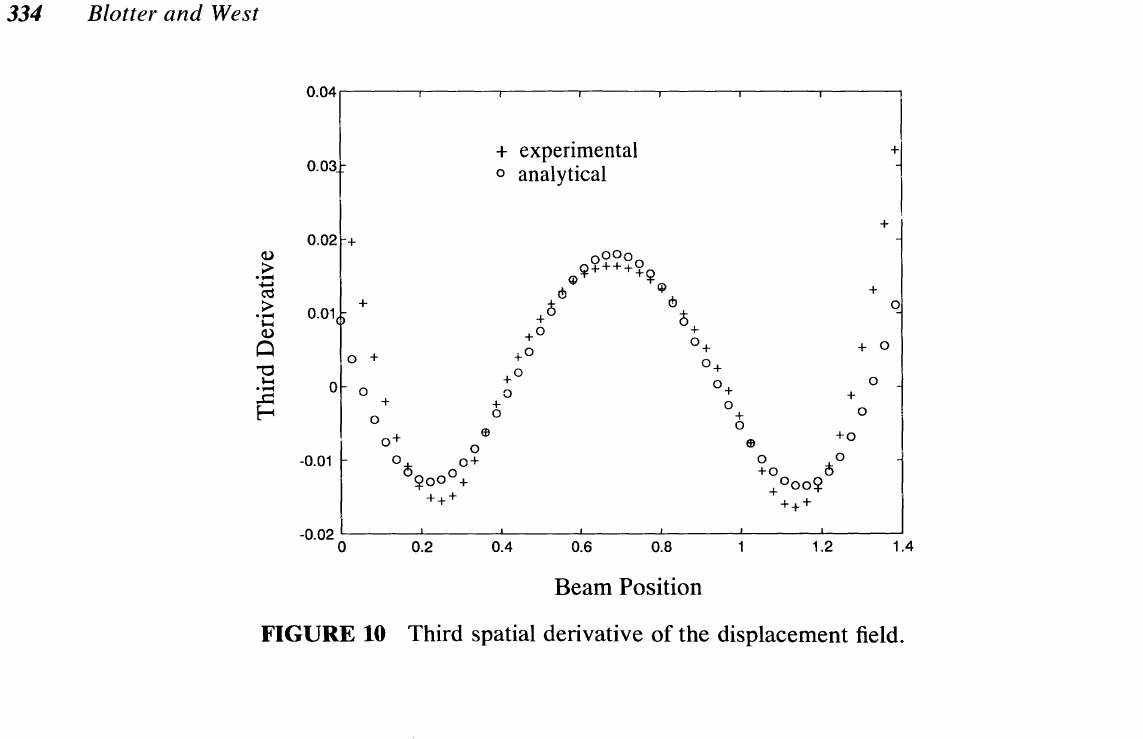
FIGURE 10 Third spatial derivative of the displacement field.